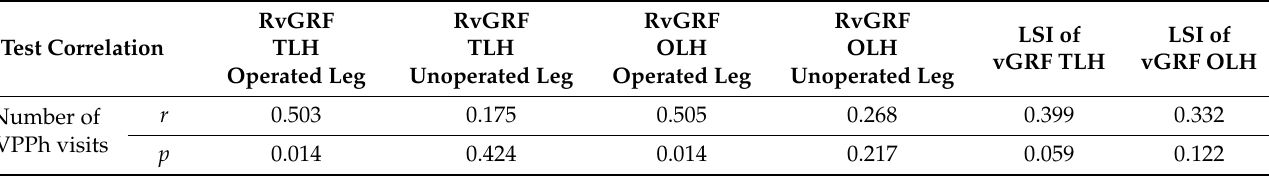
Values of relative vertical ground reaction force—RvGRF; limb symmetry index—LSI; vertical ground reaction force—vGRF; the significance level of statistical differences— p ; correlation coefficient p < 0.005—marked in bold line; two-legged vertical hops—TLH; one-legged vertical